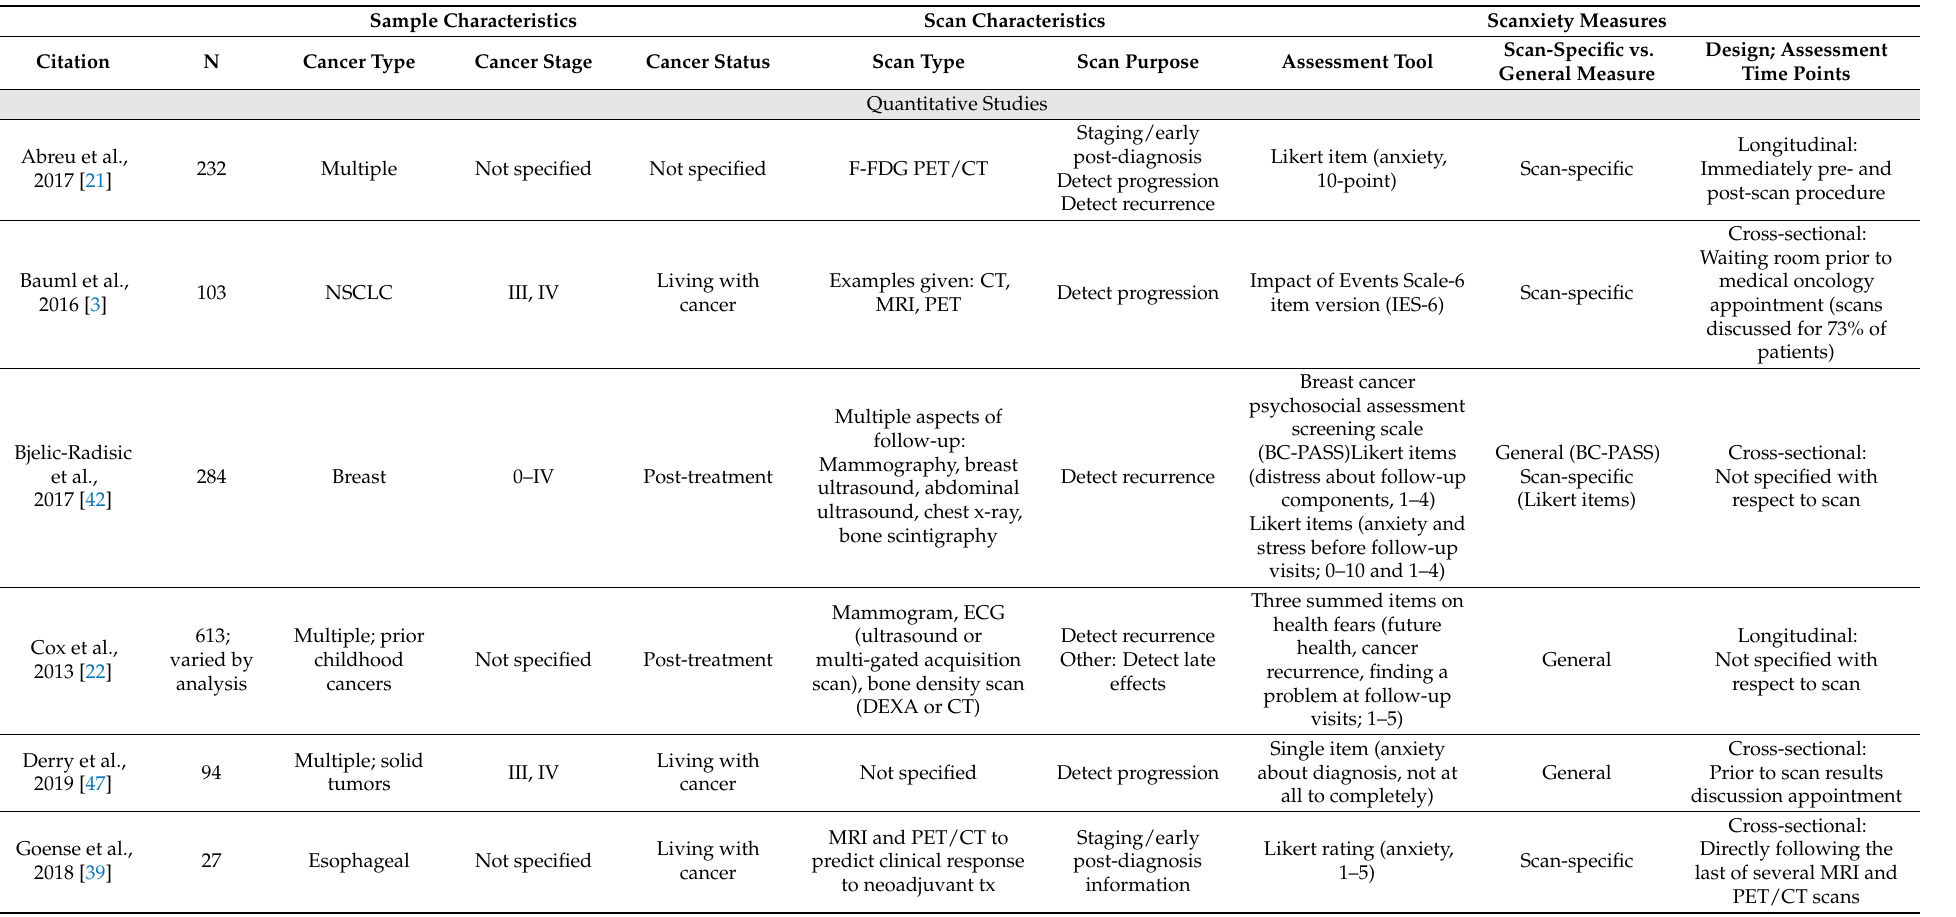
Table 3. Summary of included